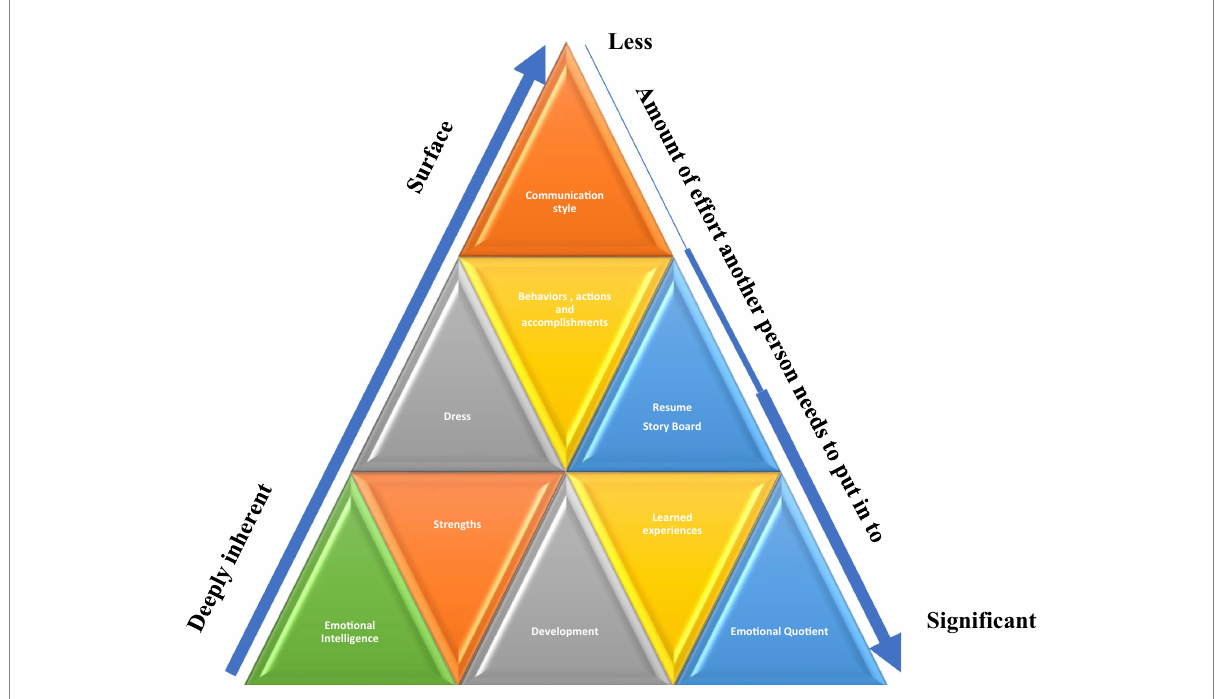
FIGURE 3 Personal Brand Triangle. The brand triangle represents the make-up of a personal and professional brand and necessary components to ensure it is not confusing to others. Features at the bottom are more deeply rooted within the individual and take longer for others to discover, gradually increasing the amount of required effort to learn more about the person’s